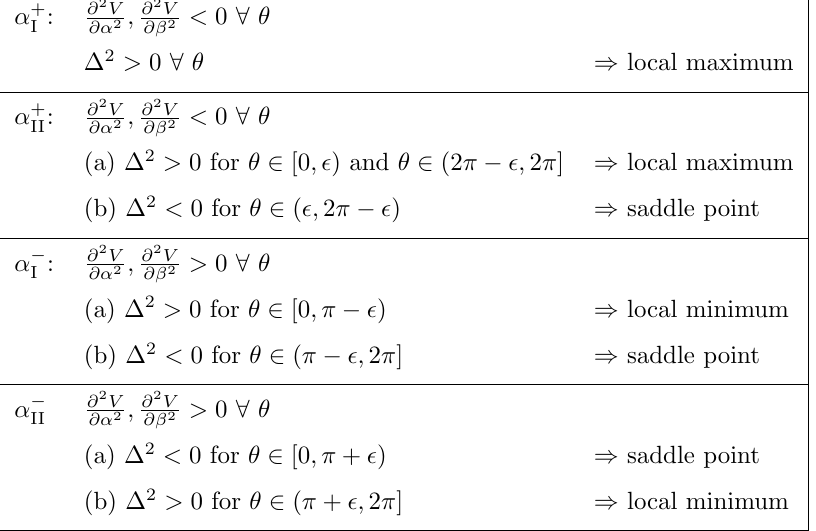
Table 2 . Classi(cid:12)cation of the stationary points of V ( (cid:11); (cid:12); (cid:18) ) considering the L 7